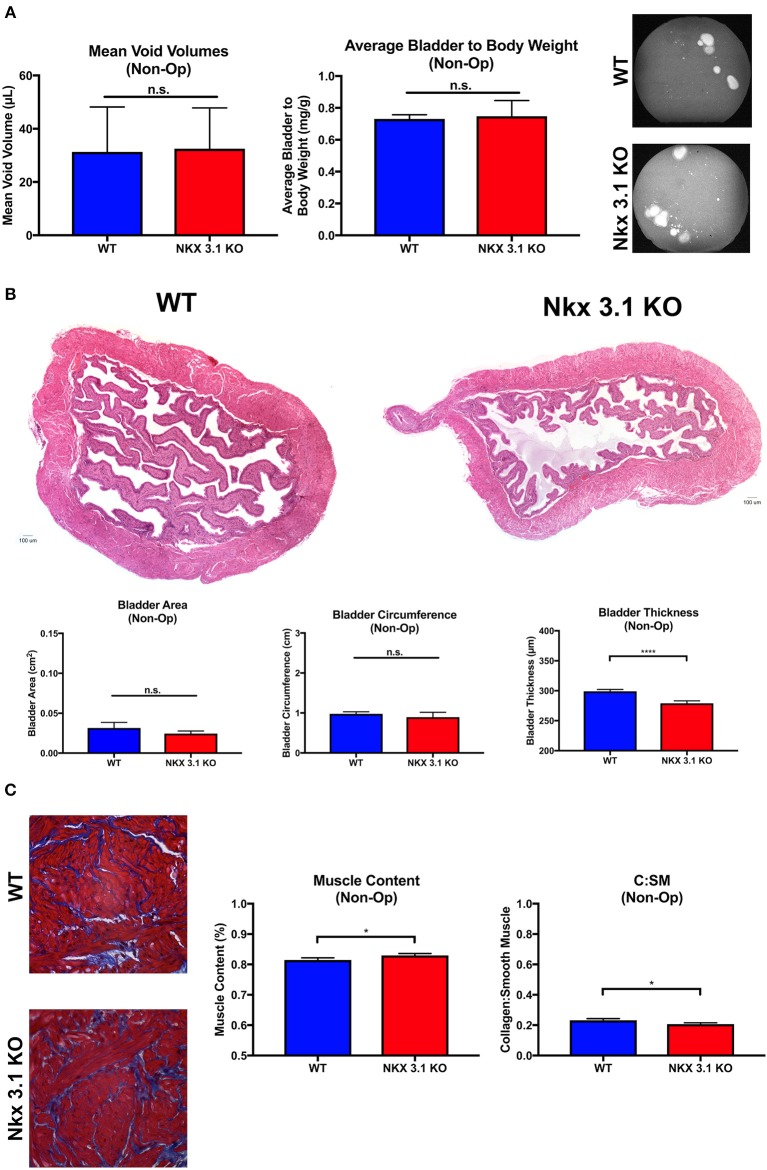
Functional and histologic analysis of unoperated WT and Nkx3.1KO/KO bladders. (A) Comparison of mVV (WT, N = 4; Nkx3.1KO/KO, N = 4), bladder: body weight ratios (WT, N = 4; Nkx3.1KO/KO, N = 4), and representative VSOP images. (B) Histologic analysis of HandE images with basic bladder metrics such as bladder area, circumference, and thickness (WT, N = 4; Nkx3.1KO/KO, N = 4). (C) MT images, muscle content, and collagen: smooth muscle ratio (WT, N = 4; Nkx3.1KO/KO, N = 4). Error bars in all graphs are represented as a standard deviation with family-wise significance and confidence level calculated at a 95% confidence interval (n.s., *P < 0.05 or ****P < 0.0001).